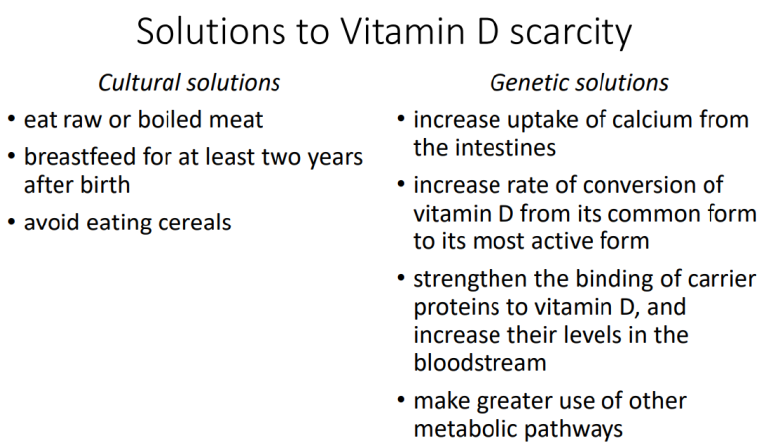
Figure 1. Solutions to vitamin D Figure 1. S olutions to vitamin D scarcity.